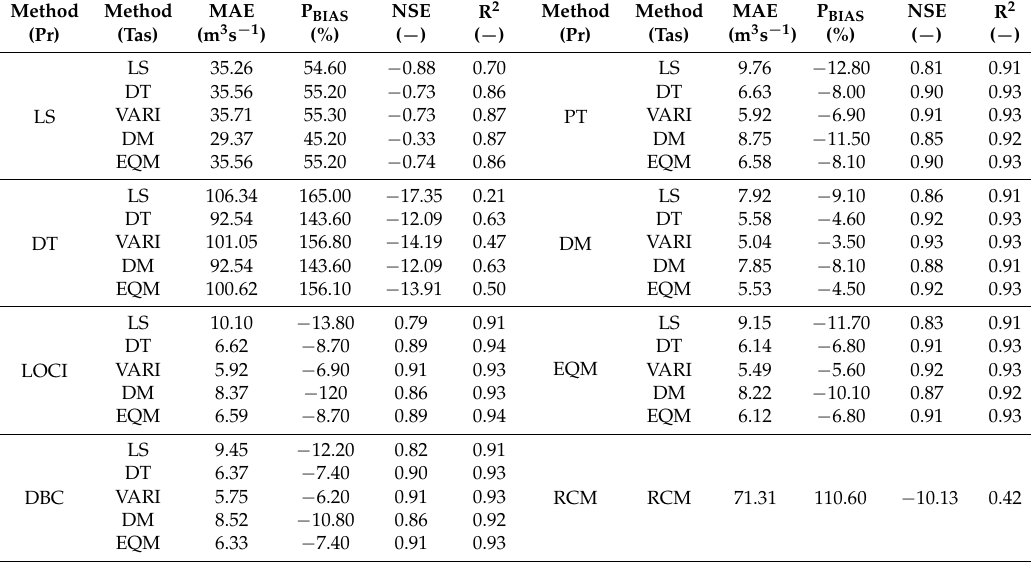
Table 4. Time-series-based metrics of simulated discharges forced by 35 combinations of corrected precipitation and temperature as well as original RCM simulations on an average daily scale at the DSK